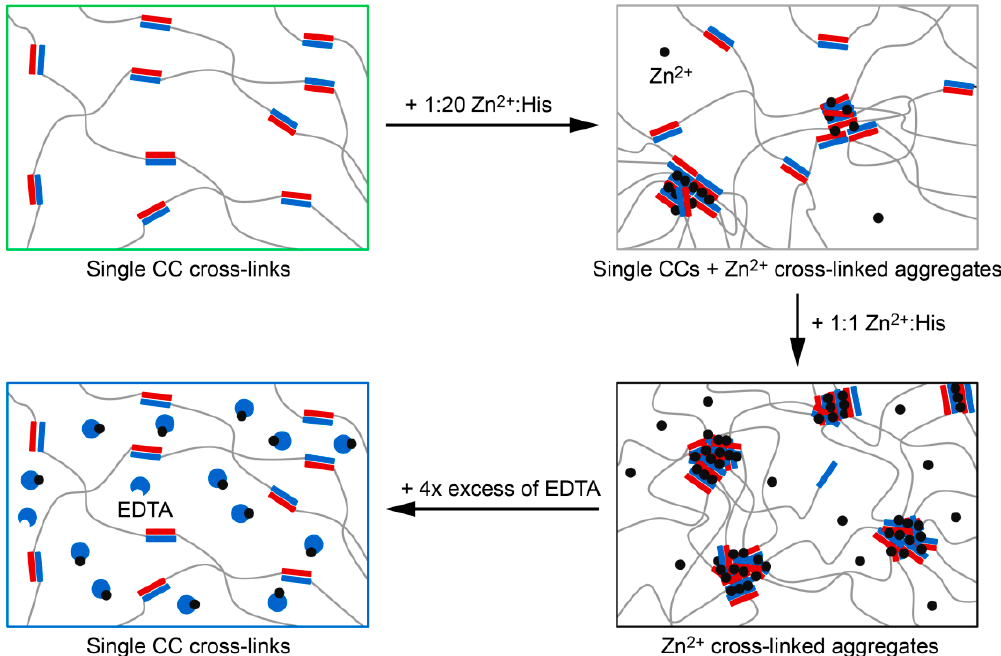
Figure 7. Scheme of the cross-linking modes in the hydrogel. In the absence of metal ions, only single coiled coil (CC) cross-links form. At 1:20 Zn 2+ :His, the hydrogel is cross-linked by a mixture of single CCs and small Zn 2+ cross-linked aggregates. At 1:1 Zn 2+ :His most of the CC-forming peptides participate in these aggregates. The formation of Zn 2+ cross-linked aggregates is fully reversible when EDTA is added.